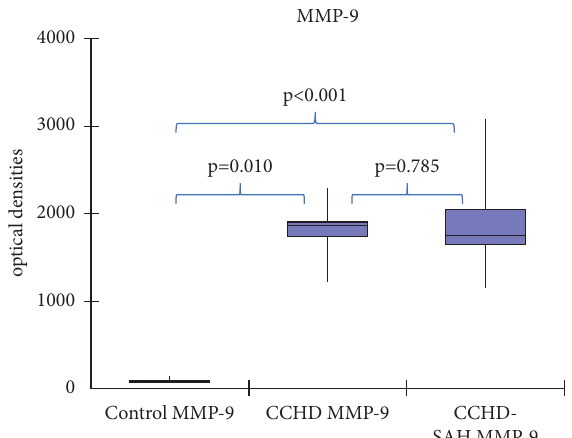
Figure 2: Comparison of MMP-9 plasma levels among controls, chronic chagas heart disease alone (CCHD), and chronic chagas heart disease-systemic arterial hypertension (CCHD-SAH) patients.